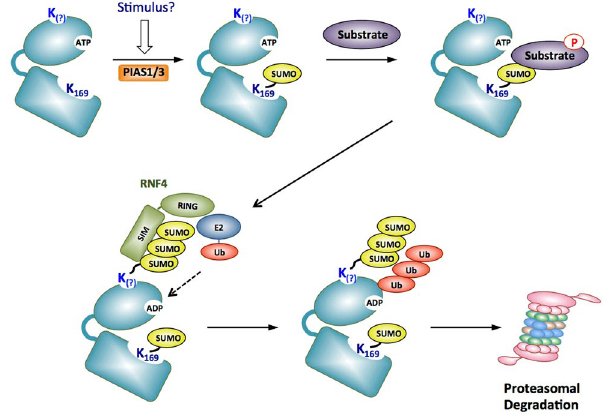
Figure 8. Model for regulation of PIM1 by SUMOylation. The bi-lobed structure of PIM1 kinase is shown in blue. The consensus SUMOylated lysine residue is located in the substrate binding pocket (K169 in deep blue). For the purpose of presentation, the non-consensus lysine is shown in blue in the N-terminal domain. Stimuli such as growth factors or stress might induce SUMOylation of PIM1 under endogenous conditions. SUMOylated PIM1 can bind and phosphorylate substrates. Once this is achieved, a SUMO targeted ubiquitin ligase is recruited to polySUMOylated PIM1 leading to attachment of polyubiquitin chains on PIM1. The SUMOylated and ubiquitylated PIM1 is then targeted for degradation by the